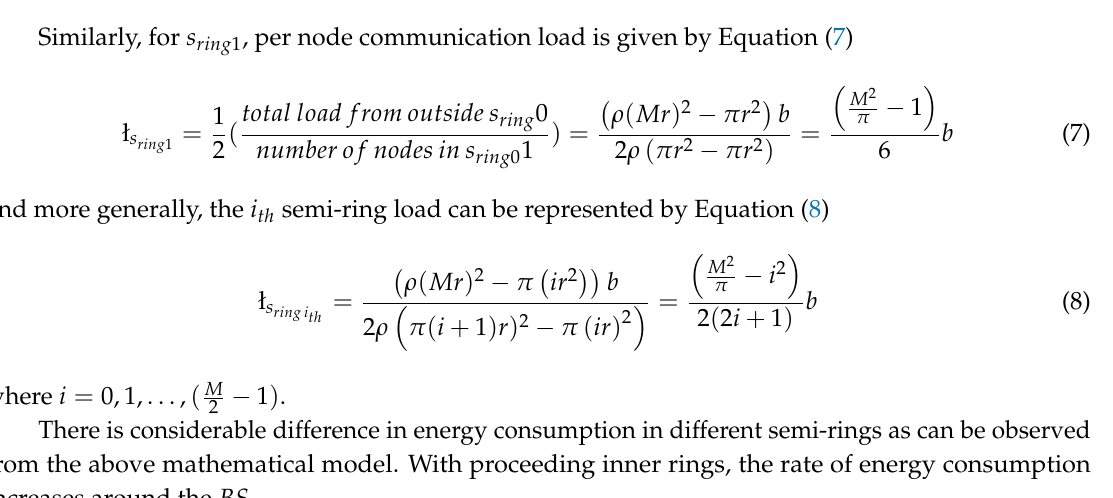
Figure 4. Energy-hole problem due to a faster rate of energy consumption around the base station (BS) and critical